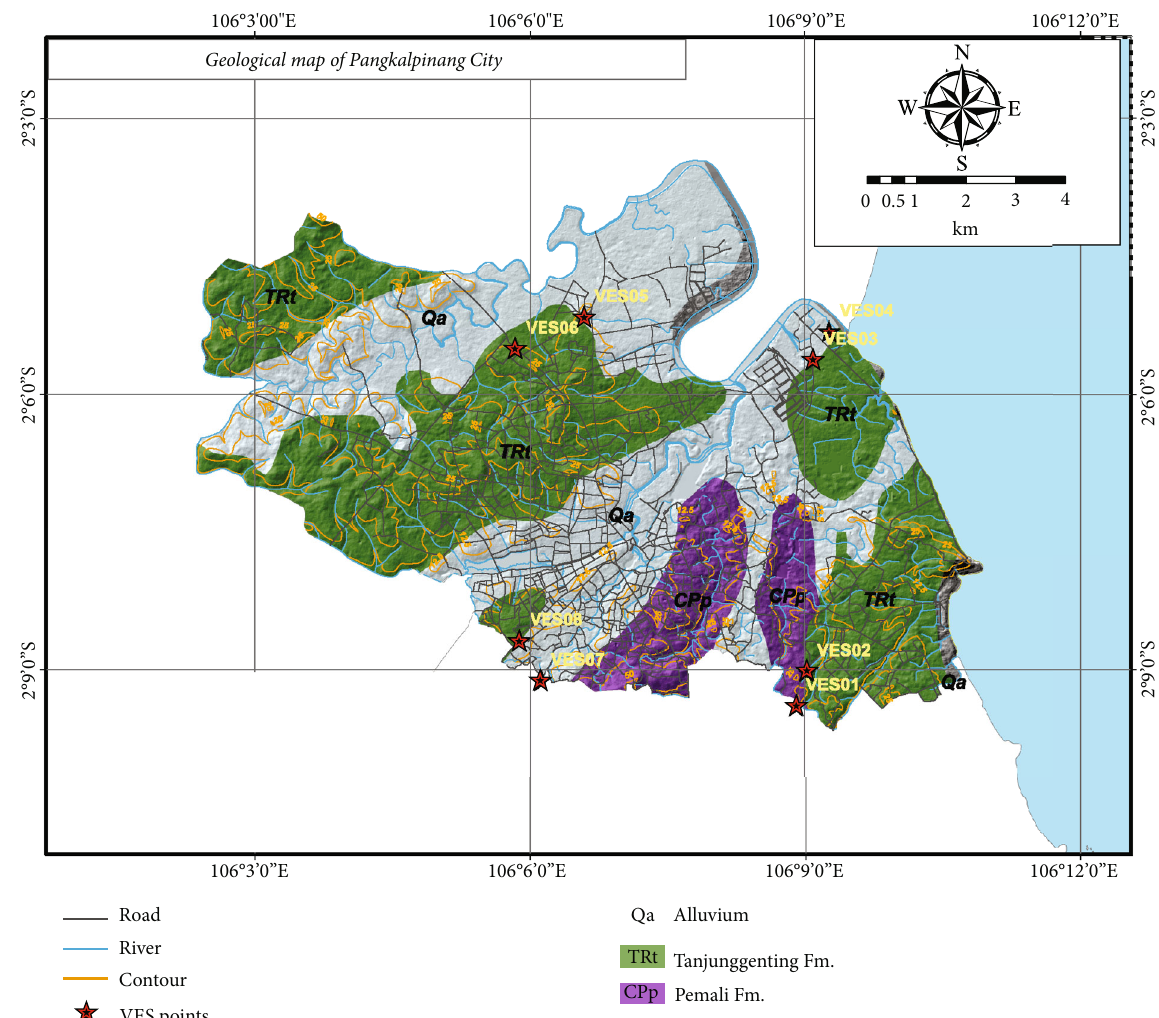
Figure 2: Geological map of the study area (from Mangga and Djamal,